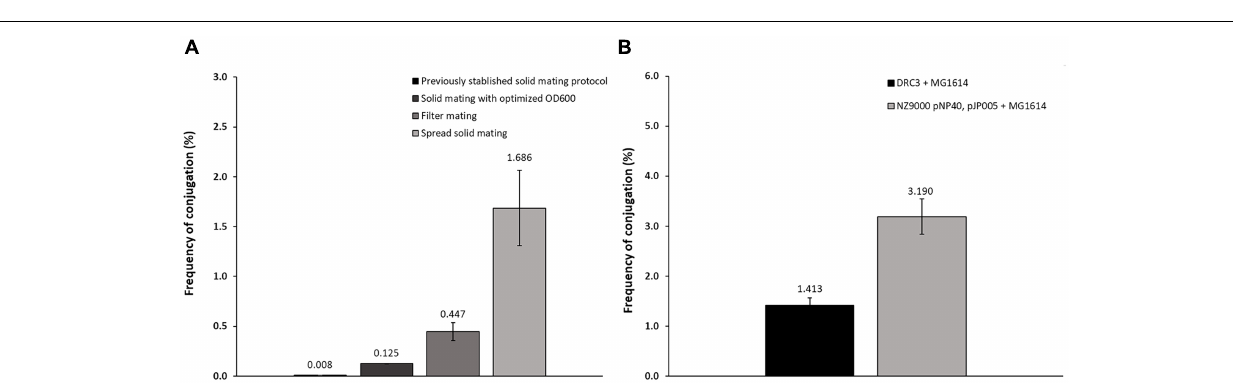
FIGURE 2 | (A) Conjugation frequencies for the different protocols employed. Following a previously established protocol (Trotter et al., 2001), conjugation frequencies achieved were around 0.008%. Varying the OD 600 nm at which the cultures were centrifuged together (0.7) allowed an increase to 0.125%. Using the filter mating protocol, the frequency increased to around 0.447%, while the spread solid mating protocol further improved conjugation to 1.686%. (B) Conjugation frequency comparison of: conjugation control (DRC3 and MG1614) and conjugation between NZ9000 pNP40, pJP005, and MG1614, showing in this “two-step conjugation” a substantial increase in conjugation frequency when compared to the